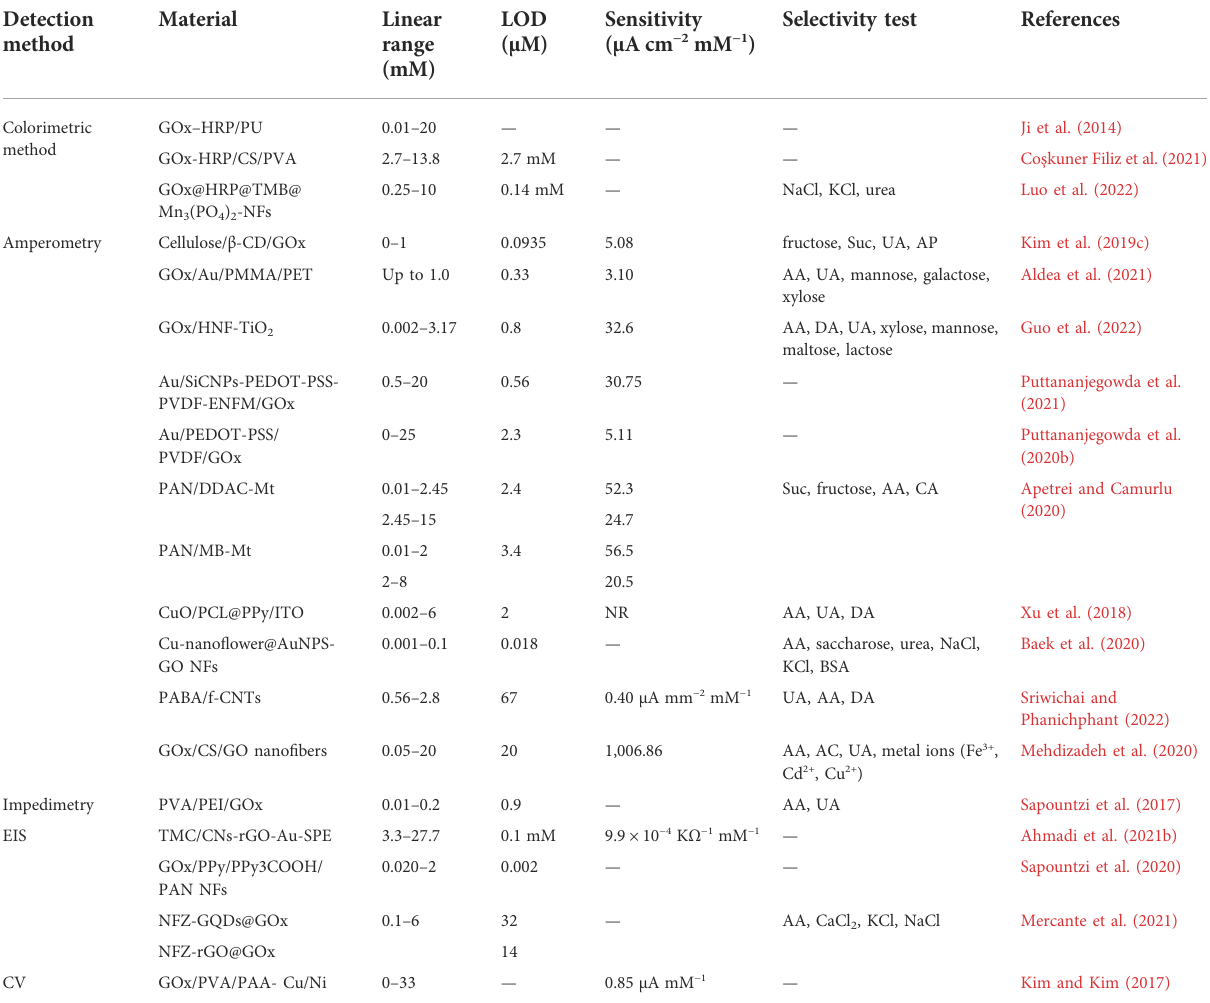
TABLE 3 Enzymatic electrospun NF-based biosensors for glucose detections, with analytical